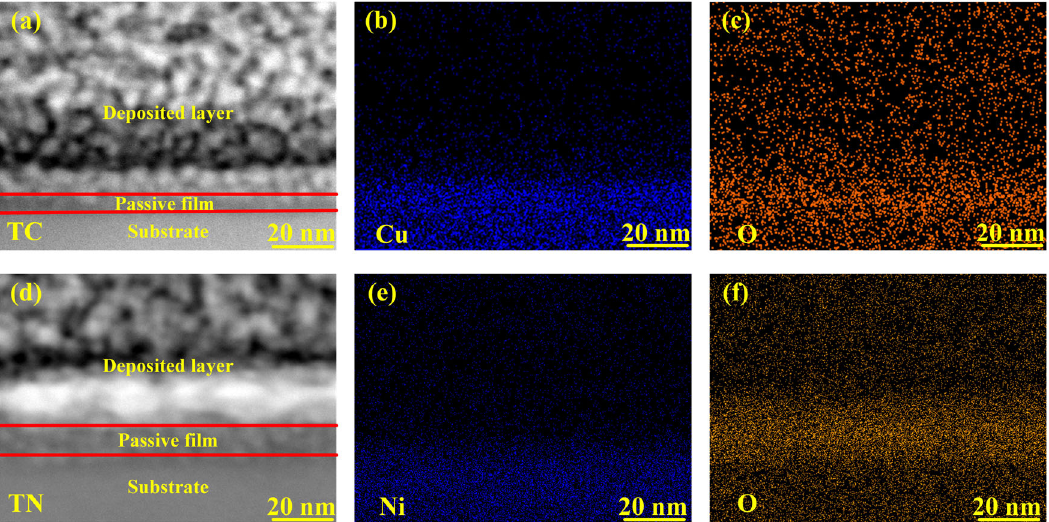
Fig. 10 TEM images of the passive fi lms of the samples at the OCP in 3.5 wt. % NaCl solution for 3600 s. a TC sample. b , c EDS mapping images of the test area corresponding to a . d TN sample. e , f EDS mapping images of the test area corresponding to d .